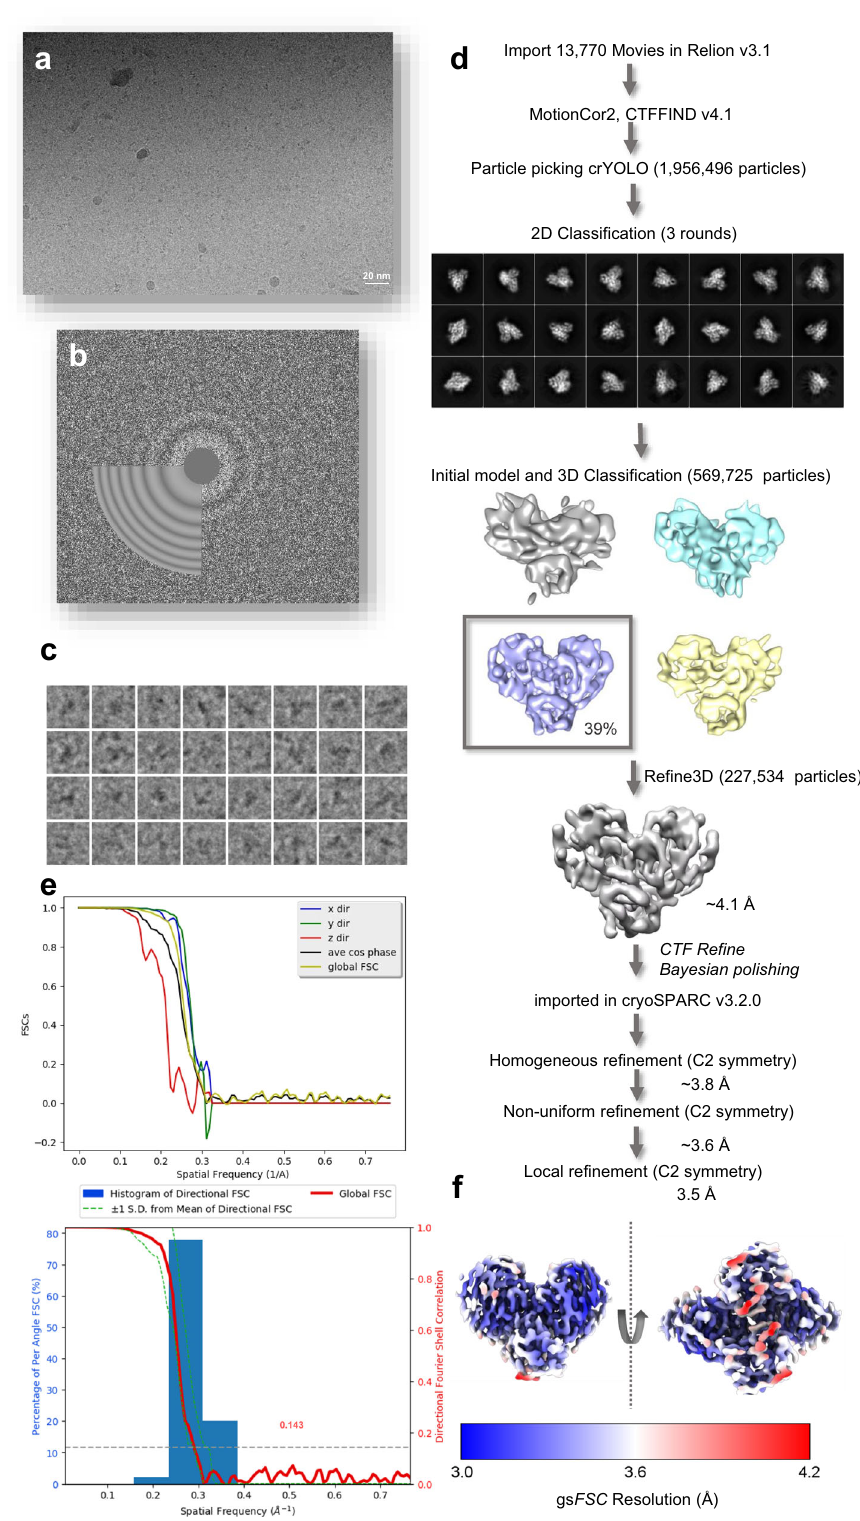
Fig.2|Cryo-EMdataprocessingschematicforC145SSARS-CoV-2M pro .a Aligned micrographs, with scale bar at the bottom. b CTF-function calculated from obtained micrographs. c Extracted particles examples. d Detailed schematic of steps taken for fi nal reconstruction, highlighting obtained 2D and 3D classes, and fi rst high-resolution reconstruction. e Fourier shell correlation (FSC) between half